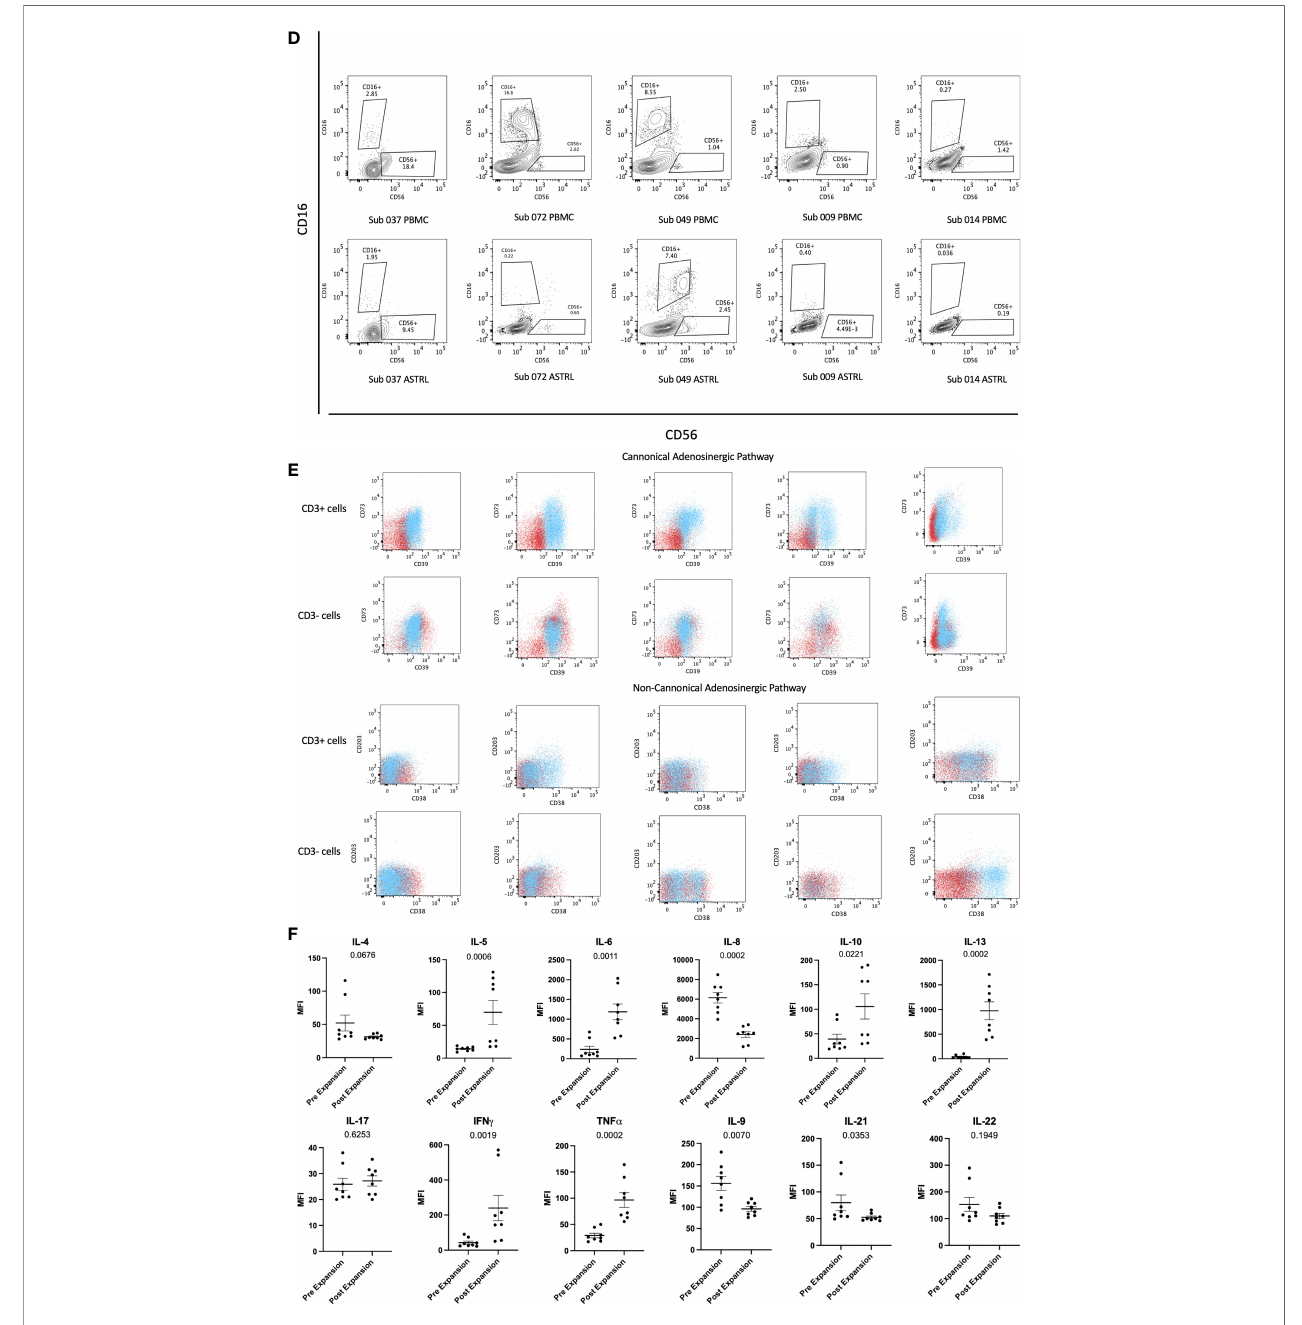
FIGURE 2 | (A) Phenotypic characterization of ASTRL. Flow cytometry plots show expression of CD25, CD127, and Foxp3 in CD4 + and CD8 + T cells of pre expansion PBMC and ASTRL. (B) Expression of various conventional T regulatory cell markers on CD4 + T cell subsets of pre-expansion PBMC and ASTR L. Histograms and contour plot overlays show PBMC in red and ASTRL in blue. (C) ASTRLs constitute a heterogenous cell population. Figures show a comparison of CD19 + B cell and CD11b + myeoid cell populations in pre-expansion PBMC (top panel) and ASTRL (bottom panel) from fi ve different subjects. (D) ASTRLs constitute a heterogenous cell population. NK cell population in ASTRLs (bottom panel) and pre expansion PBMC (top panel) are shown from fi ve different subjects. (E) ASTRLs upregulate the surface expression of the molecules belonging to canonical (CD39 and CD73) and non-canonical (CD38 and CD203) adenosinergic pathways. Figures on the top panels show the expression of CD39 and CD73 on the CD3 + and CD3 − cell populations of ASTRL in blue and pre-expansion PBMC in red. The bottom panel shows the expression of CD38 and CD203 in CD3 + and CD3 − subsets of ASTRL in blue and pre-expansion PBMC in red. (F) Differentially expressed cytokines in the expansion media of ASTRLs. Post expansion, on days 30 – 35 ASTRLs were harvested and production of various cytokines in the spent expansion media were measured by